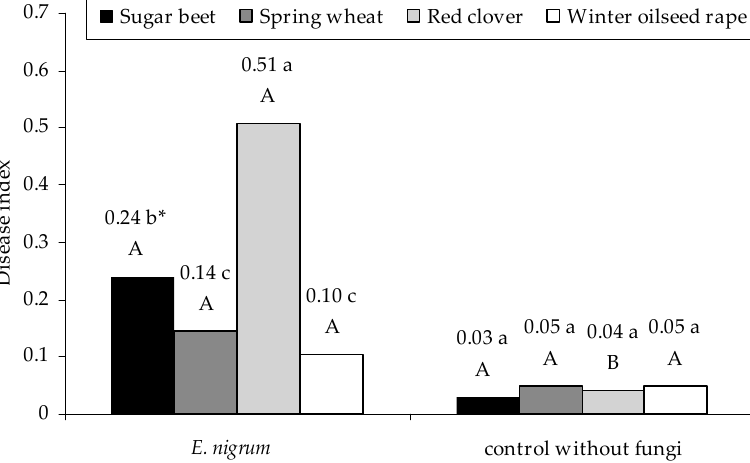
Figure 7. Disease index of seedlings of sugar beet ( B. vulgaris L. ssp. vulgaris ), spring wheat ( T. aestivum L.), red clover ( T. pratense L.), and winter oilseed rape ( B. napus L.) colonized by 18 strains of E. nigrum . Means followed by the same letter (*) are not statistically different at the α ≤ 0.01 level, according to the Tukey HSD test. Small letters indicate the differences in the plants infection index within E. nigrum strains and the control group. Capital letters indicate the differences in the infection index of a given plant between E. nigrum strains and the control group.